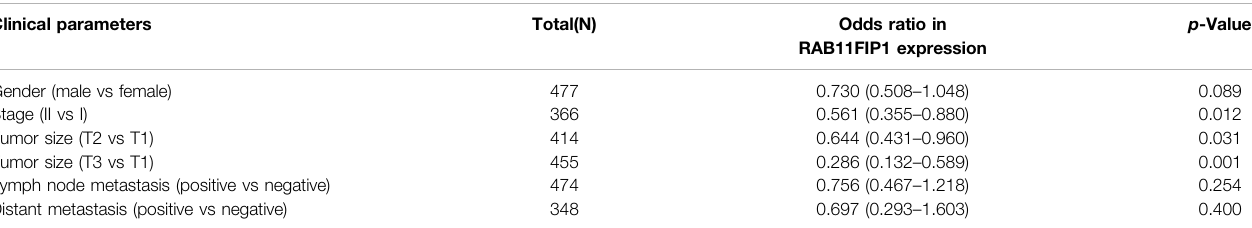
TABLE 1 | Association between RAB11FIP1 expression and clinicopathologic parameters by Logistic regression. Clinical